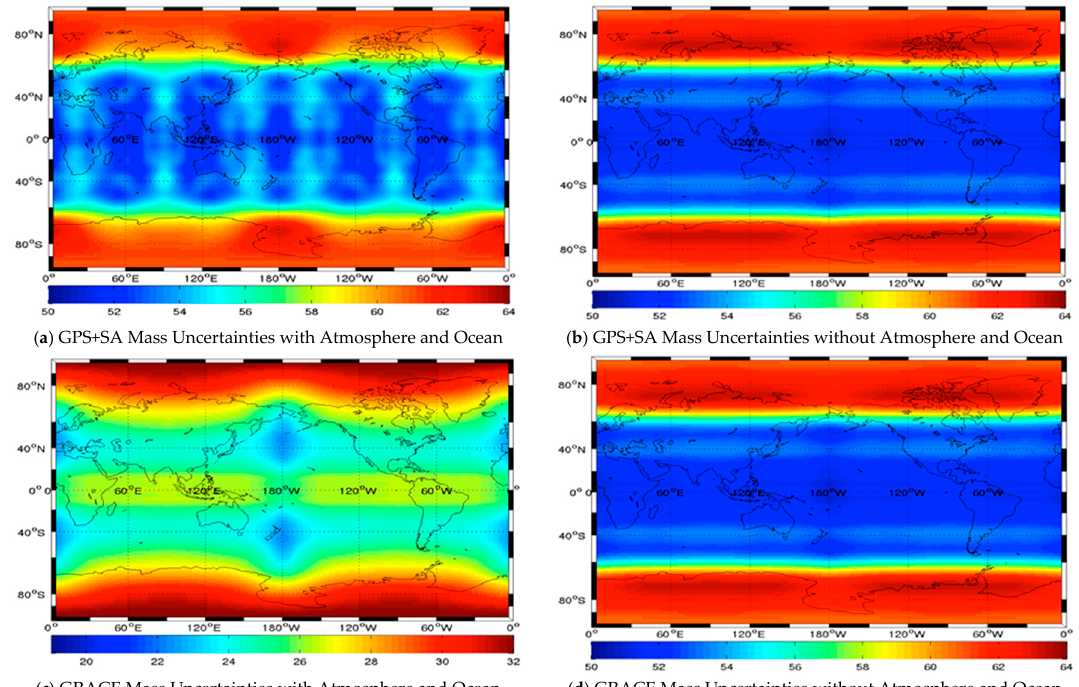
Figure 14. Uncertainties of mass errors (in millimeter) estimated from GPS+SA and GRCE after a Gaussian filter with half wavelength at 500 km is applied to both. The used Stoke’s coefficients of GRACE+SA and GRACE are 120-month values in the period 2003–2012. GRACE degree-1 coefficients come from [38]. C(2,0) of GRACE is replaced with C(2,0) of SLR [10]. ( a ) The GPS+SA mass error with atmosphere and sea. Its global average is 53.99 mm. ( b ) The GPS+SA mass error without atmosphere and sea. Its global average is 53.36 mm. ( c ) The GRACE mass error with atmosphere and sea. Its global average is 25.50 mm. ( d ) The GRACE mass error without atmosphere and sea. Its global average is 22.27 mm.